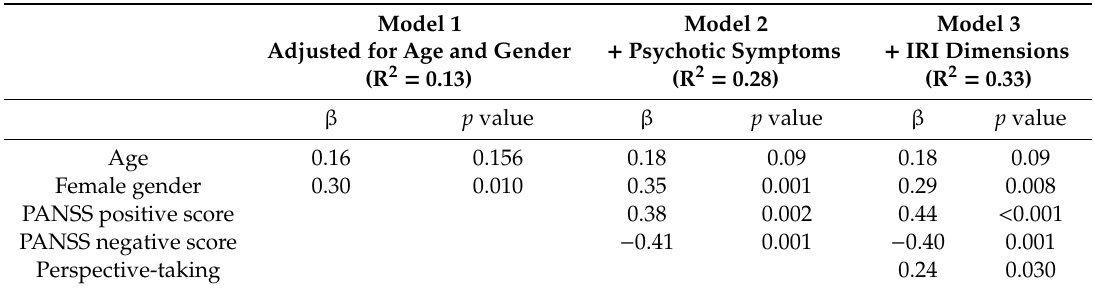
Table 2. Results of the multiple regression exploring the relationship between overall religiousness and interpersonal reactivity (IRI) measures in patients with